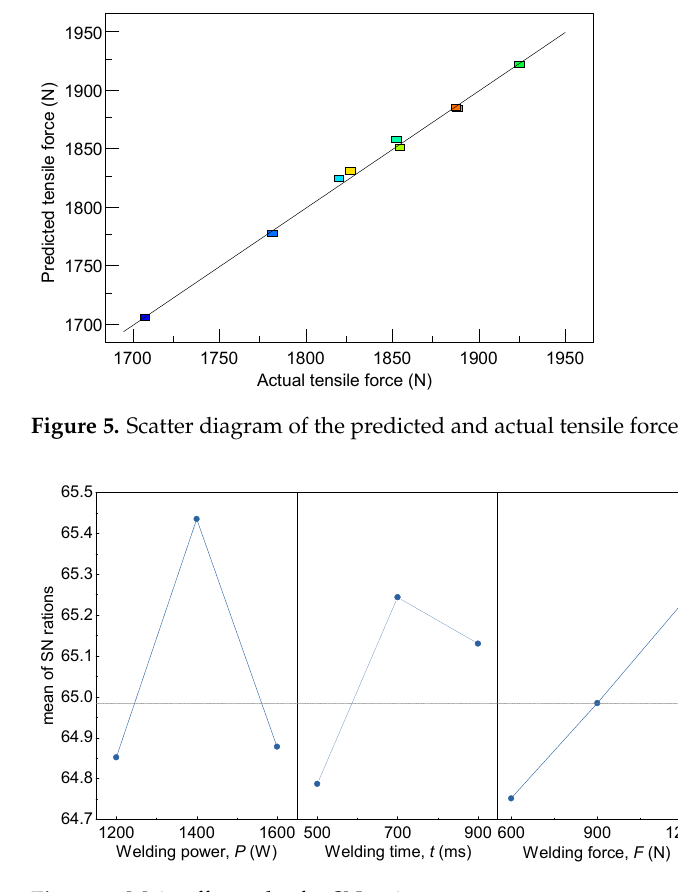
Figure 6. Main effects plot for SN rations.